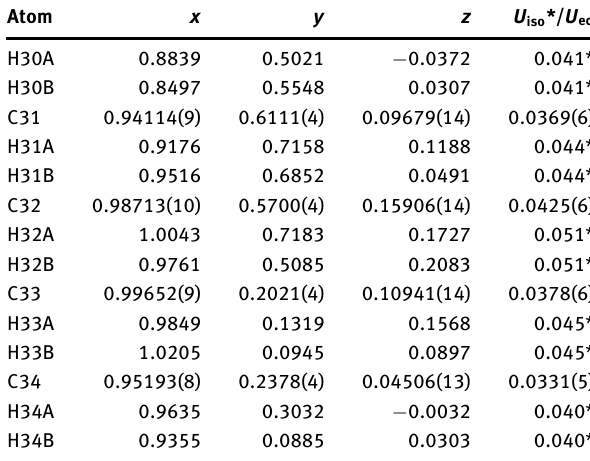
Table 2: Fractional atomic coordinates and isotropic or equivalent isotropic displacement parameters (Å 2